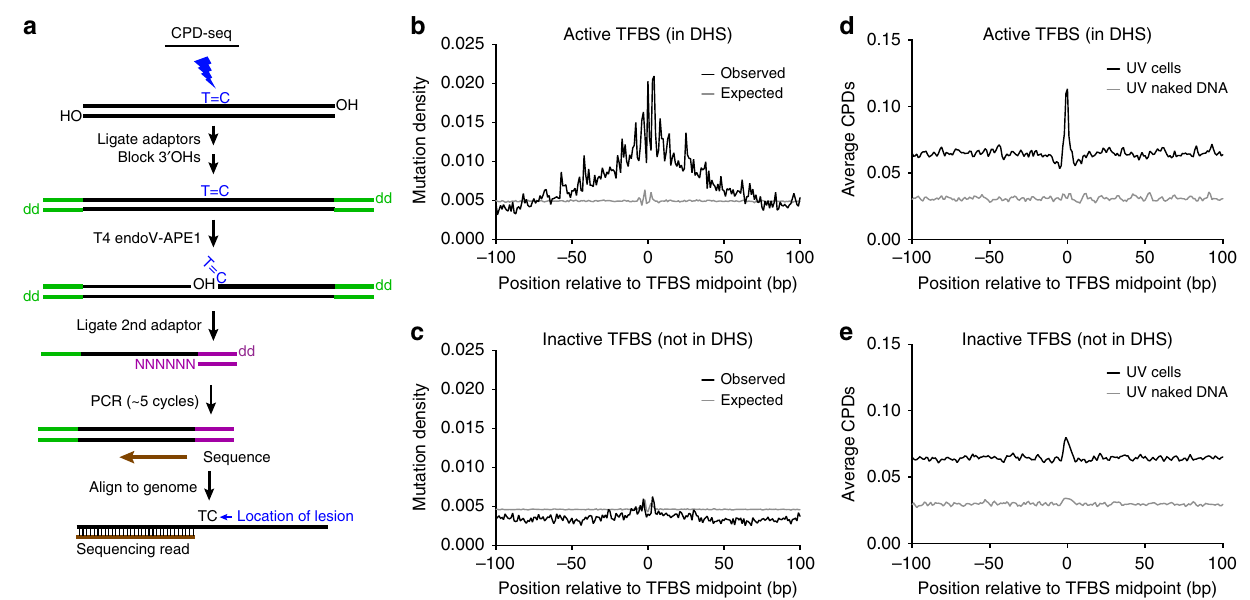
Fig. 1 Genome-wide map of CPD lesions reveals that CPDs are elevated at active TFBS. a Schematic diagram of the CPD-seq method for mapping CPD lesions at single nucleotide resolution. ‘ T = C ′ indicates a CPD lesion at TC dipyrimidine. Oligonucleotide adapters are indicated in green and purple; ‘ NNNNNN ′ indicates a random DNA hexamer. A 3 ′ hydroxyl is indicated with OH, while ‘ dd ’ indicates a dideoxy 3 ′ end. The CPD lesion is cleaved with T4 endonuclease V and apurinic/apyrimidinic endonuclease (APE1) to generate a free 3 ′ hydroxyl immediately upstream of the CPD lesion, which is ligated to an adapter and sequenced. b Mutation density surrounding active promoter-proximal TFBS from 184 sequenced melanoma tumors 18 . Observed mutation density (i.e., in melanoma tumors) was analyzed adjacent to known TFBS located in promoter-proximal regions (up to 2500 bp upstream of transcription start site) that were considered active (i.e., overlapping with melanocyte DNase I-hypersensitivity (DHS) regions) for 82 distinct TFs. Expected mutation density was determined from the corresponding DNA sequences surrounding each active promoter-proximal TFBS, based on the trinucleotide mutation signature frequencies for all promoter-proximal regions. c Same as part ( b ), except mutations were analyzed adjacent to promoter-proximal TFBS that were considered inactive (i.e., not overlapping with melanocyte DHS regions). d Average number of CPD lesions (per TFBS) adjacent to active promoter- proximal TFBS. CPD lesions were mapped using CPD-seq from UV-irradiated NHF1 cells (100 J m − 2 ) or isolated NHF1 DNA that was UV-irradiated (80 J m − 2 ) in vitro (naked DNA). Cellular DNA was harvested immediately after UV irradiation, so essentially no repair was allowed to occur. e Same as in part ( d ), except CPD lesions were analyzed adjacent to inactive promoter-proximal